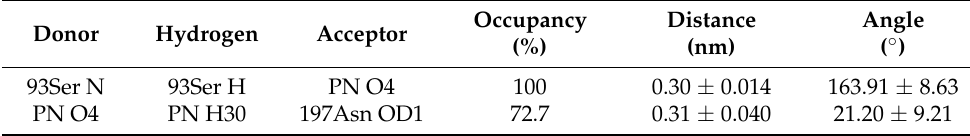
Figure 4. The residue energy contribution details. ( A ) The general catalogue of all kinds of energy and residues involved in the interaction. ( B ) The total energy contributions of residues that interact with piceatannol. ( C ) The electrostatic energy contributions of residues that interact with piceatannol. ( D ) The VDW interaction energy contributions of residues that interact with piceatannol. ( E , F ) The polar and nonpolar solvation energy contributions of residues that interact with piceatannol. Table 2. The H-bonds details between PFO and